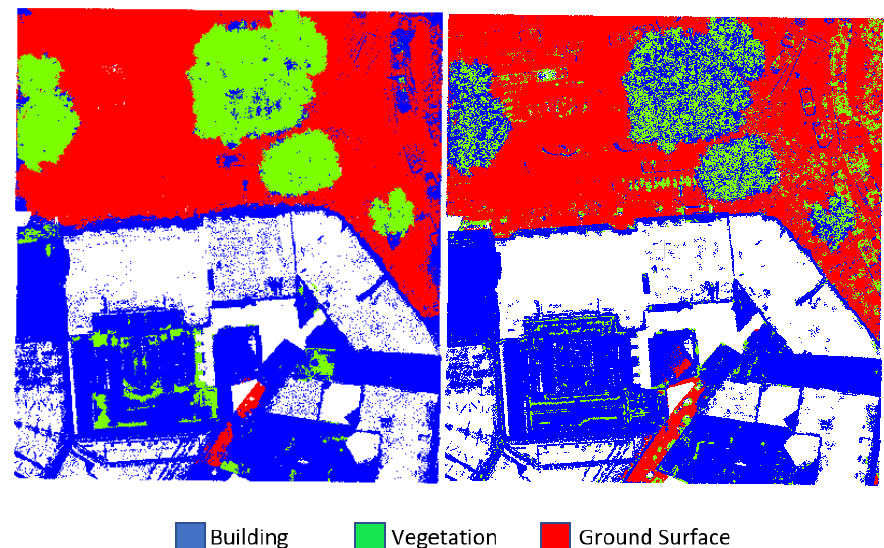
Figure 6. The best result (RF with R 3 ) and the worst (SVM in R 0.5 ) results from Dublin City Area 1. (Result of the RF is on the ( left ); result of the SVM on the ( right )). In Dublin City Area 2, 6 out of 8 methods presented the best results when using a support radius of 3 m. The GNB and KNN methods achieved the highest overall accu- racy using supports R 05 and R 1.5 , respectively. In the Dublin dataset, GNB and KNN methods were successful with a smaller support radius. MLP and SVM had better overall accuracy with 92.78% (Figure 7) and 91.59%, respectively. The least accurate method was the LDA method with 84.79% overall accuracy (Figure 8). The overall accuracy of the all methods in Dublin City Area 2 was represented in Table 4. Table 4. The overall accuracy of the methods in Dublin City Area 2. The highest-obtained accura- cies are shown as bold.